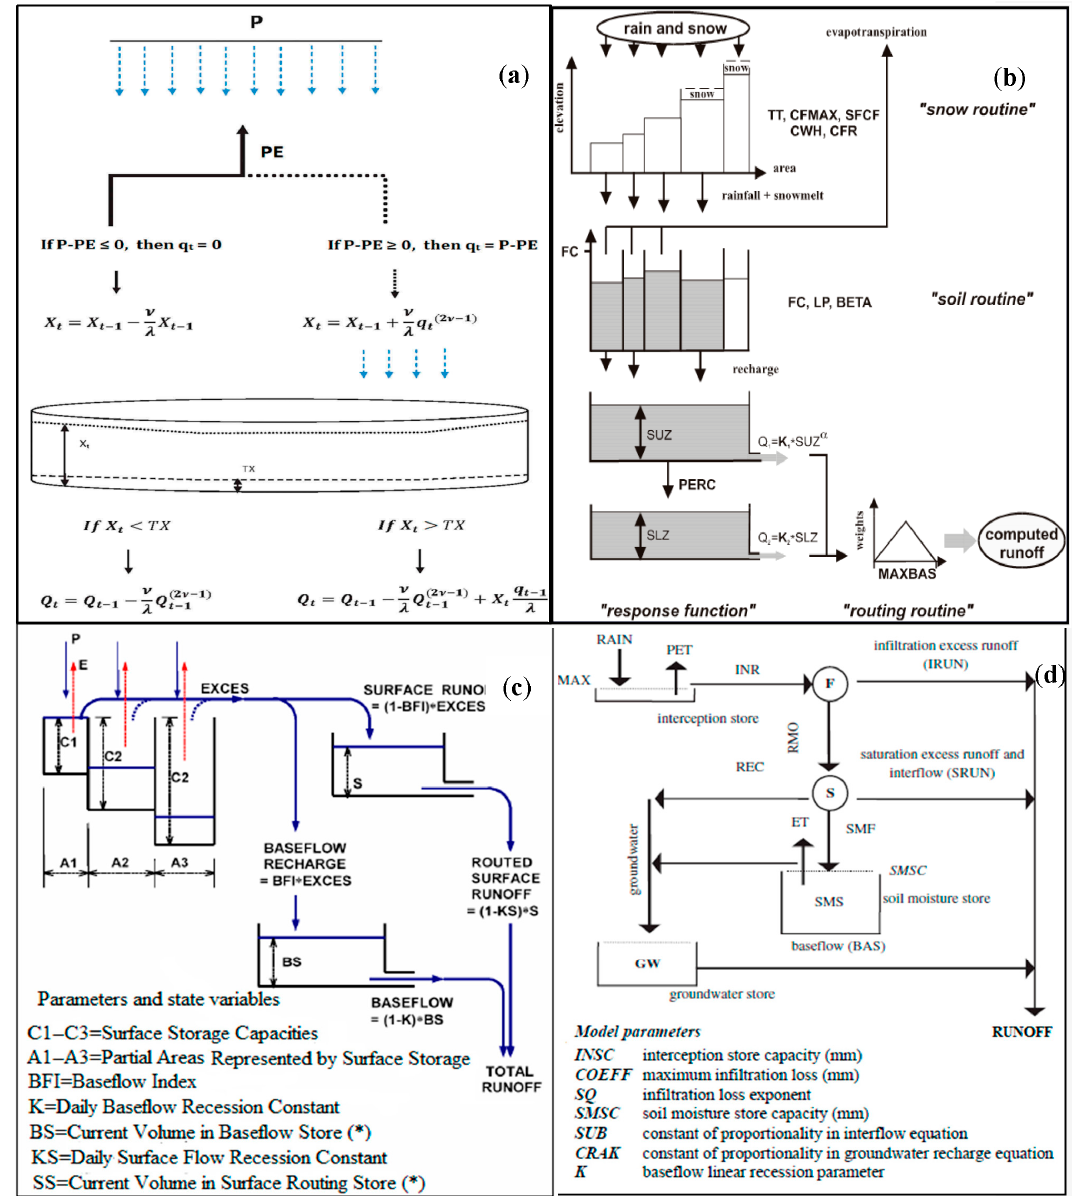
Figure 3. Schematic structure of ( a ) ModHyPMA [33]; ( b ) HBV [36]; ( c ) AWBM [37]; and ( d ) SimHyd [37].